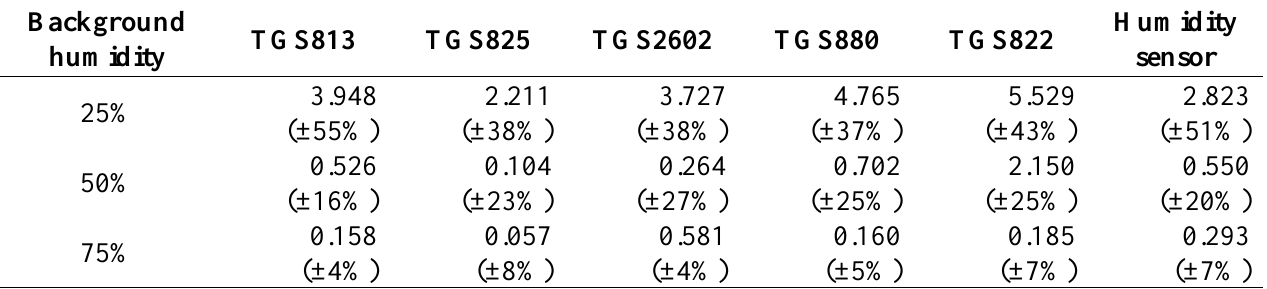
Table 3. The absolute average percentage change of resistance of each sensor upon varying humidity generated by hardware correction.